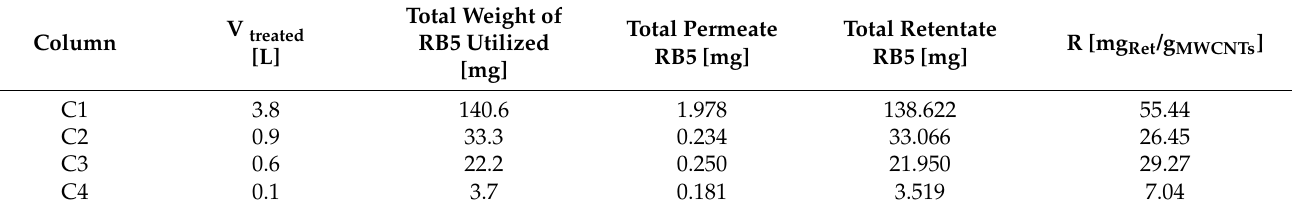
Table 4. Total amount of permeate and retentate RB5 and hydraulic ratio for different columns.